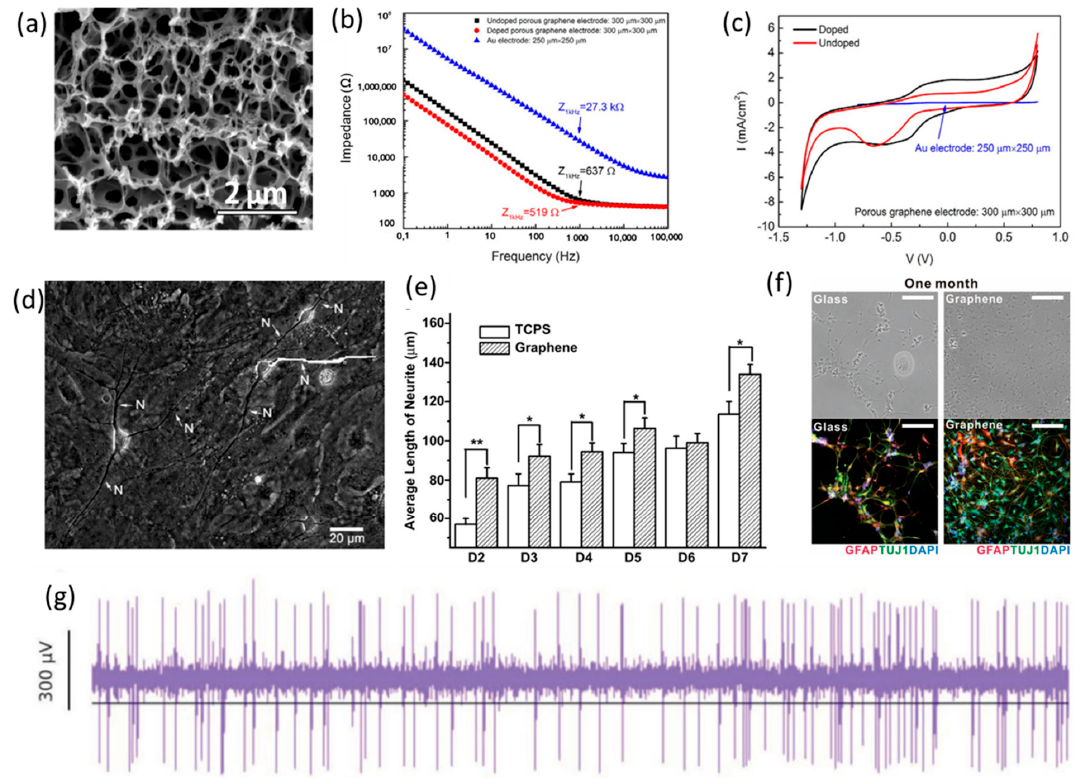
Figure 5. ( a ) SEM image of the 3D porous graphene. ( b ) EIS of a comparison of doped and undoped porous graphene and Au electrodes. ( c ) CV - characterization of porous graphene and Au electrodes. ( a – c ) are reproduced with permission from [158], Copyright 2016, Springer Nature. ( d ) Phase - contrast micrograph of typical neurons showing a trace along the ex- tension of neurite (N) used for length calculation, ( e ) average number of neurites per neuron on TCPS and graphene during the developing period (D2–D7). ( d , e ) are reproduced with permission from [148], Copyright 2011, Elsevier. ( f ) Bright-field (top row) and fluorescence (bottom row) images of hNSCs differentiated on glass (left) and graphene (right)